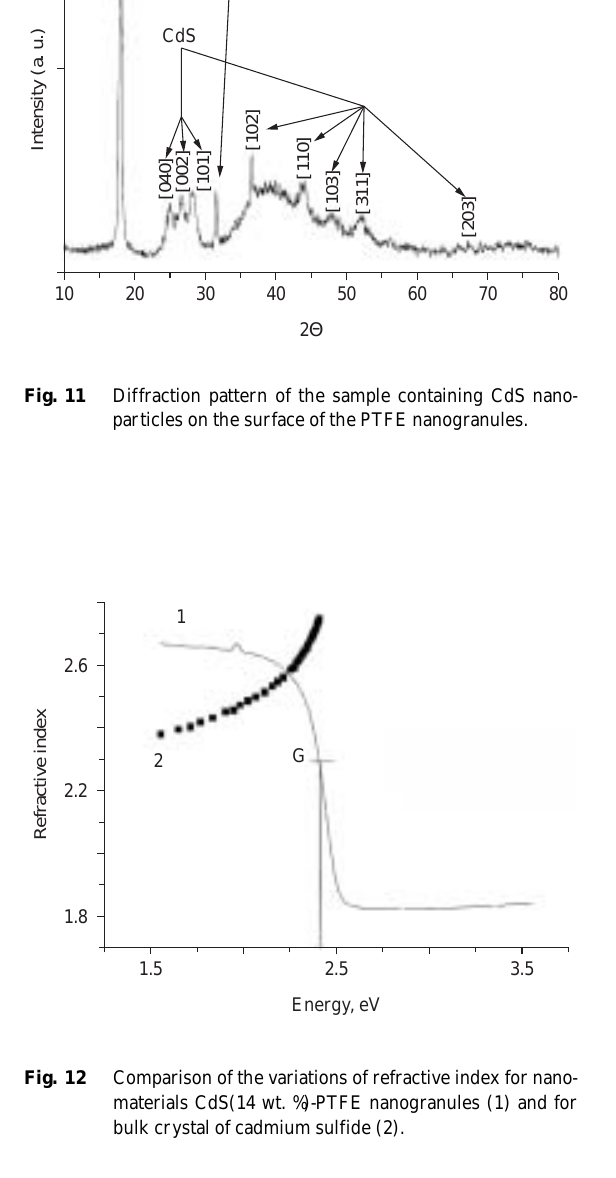
face composition of nanoparticles. Fig. 13 demonstrates the variations of the refrac- tive index and absorption spectrum of the CdS-PTFE composite. The spectrum shows that a doping by manganese in a quantity up to 2 wt. % from weight of CdS does not change the spectral characteristics as a whole, but leads to a small shift of the absorption edge to the shorter optical wave length.